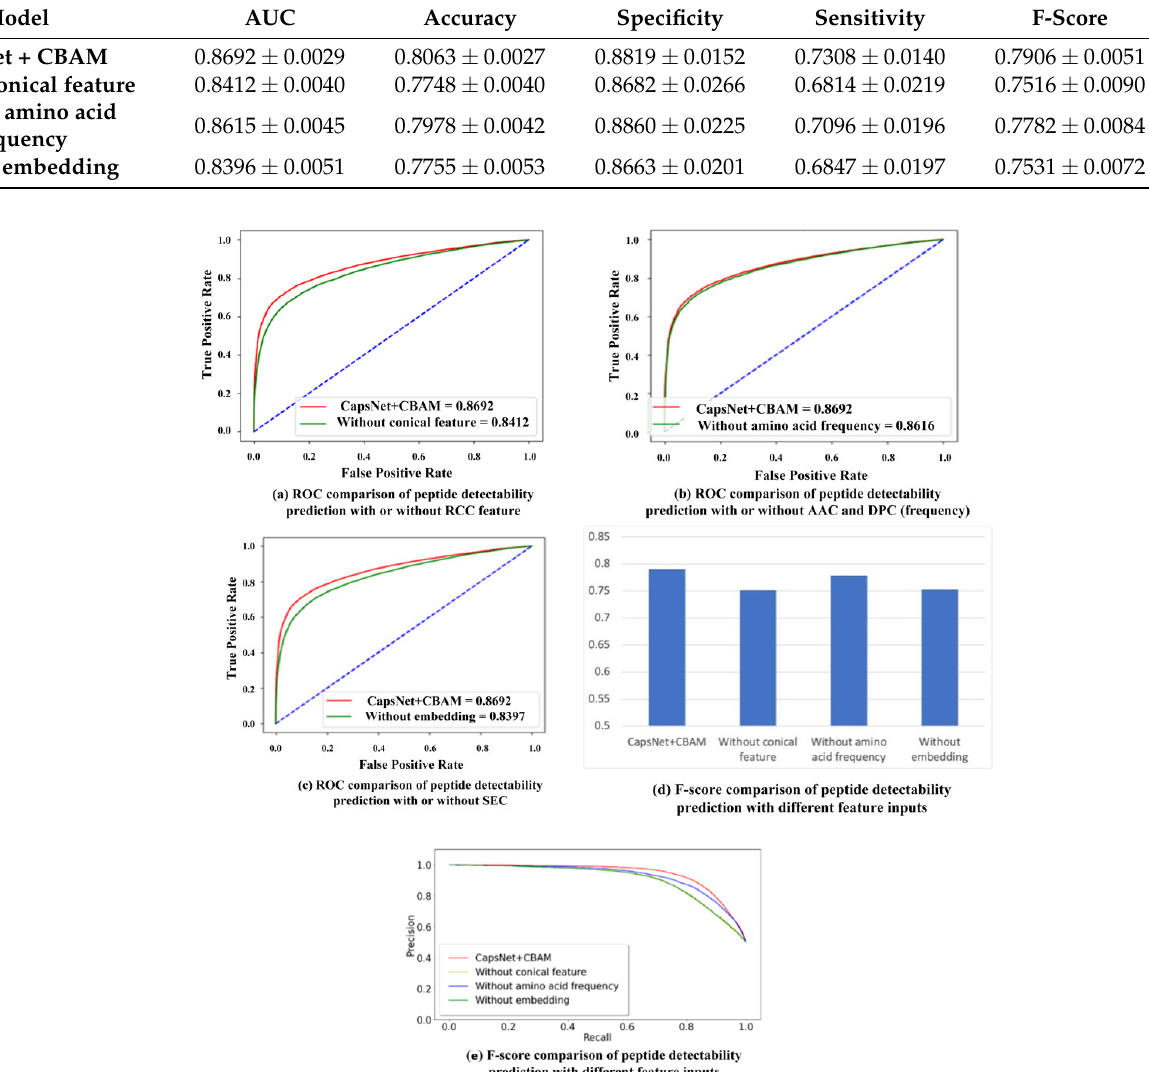
Table 1. Performance comparison by different feature inputs for peptide detectability prediction on the test set from GPMDB.